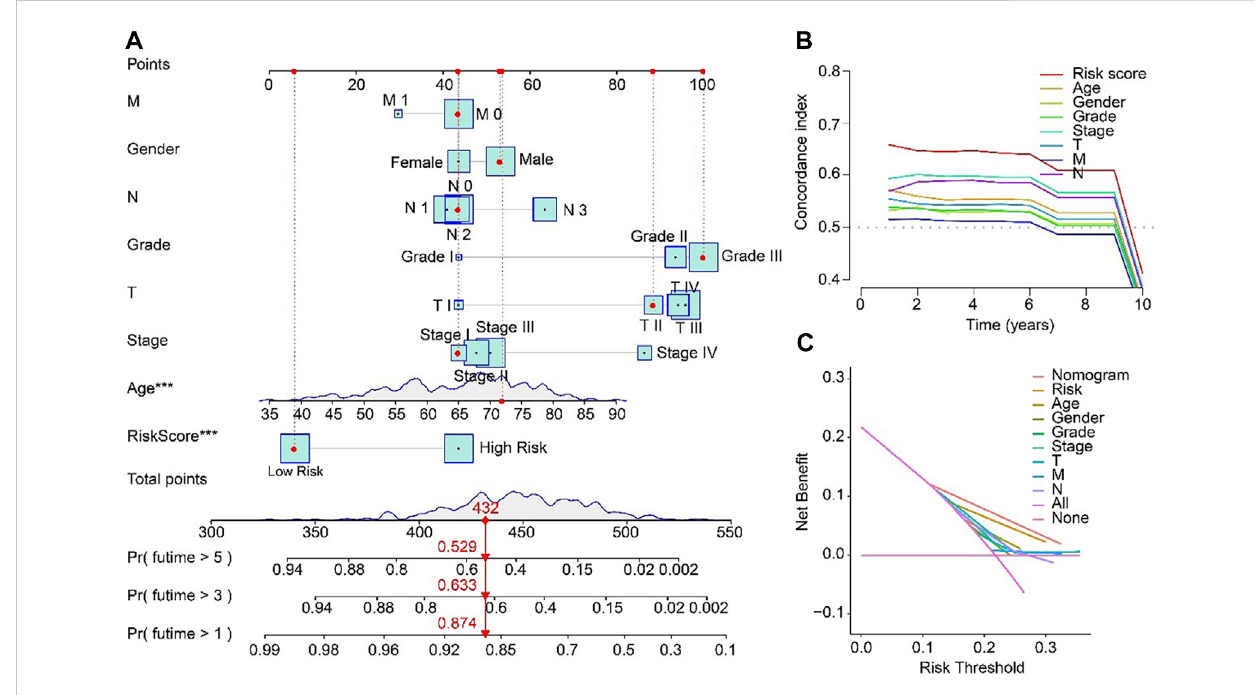
FIGURE 6 Nomogram model based on risk score for STAD patients in TCGA. (A) Nomogram construction of the ARLs prognostic signature and clinicopathological characteristics. (B) Concordance index and (C) Decision curve analysis (DCA) for the